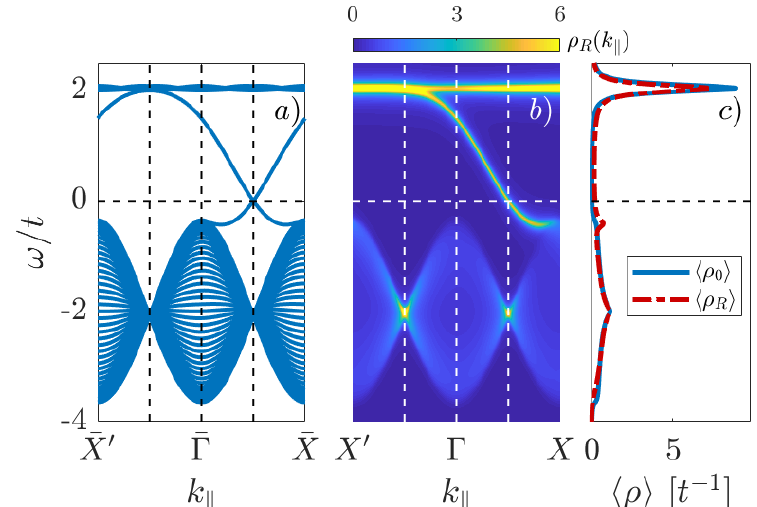
Figure 6: Open boundary characterization for the Checkerboard lattice model show- ing topological flat band at ω/ t = 2 with a chiral edge mode in the topological phase (cid:112) (cid:112) φ = − π/ 4, t (cid:48) = − t (cid:48) = t / ( 2 + 2 ) and t (cid:48)(cid:48) = − t / ( 2 + 2 2 ) . a) Electronic bands ob- 1 2 = 20 sites with the tained by exact diagonalization of a finite size system with N sites unit cell doubled. The spectrum shows 2 chiral edge states each one associated to a different boundary. b) Spectral density for a right boundary in the semi-infinite limit obtained from the bGF calculation. c) Integrated LDOS where straight (dot-dashed) line represents bulk (right boundary)